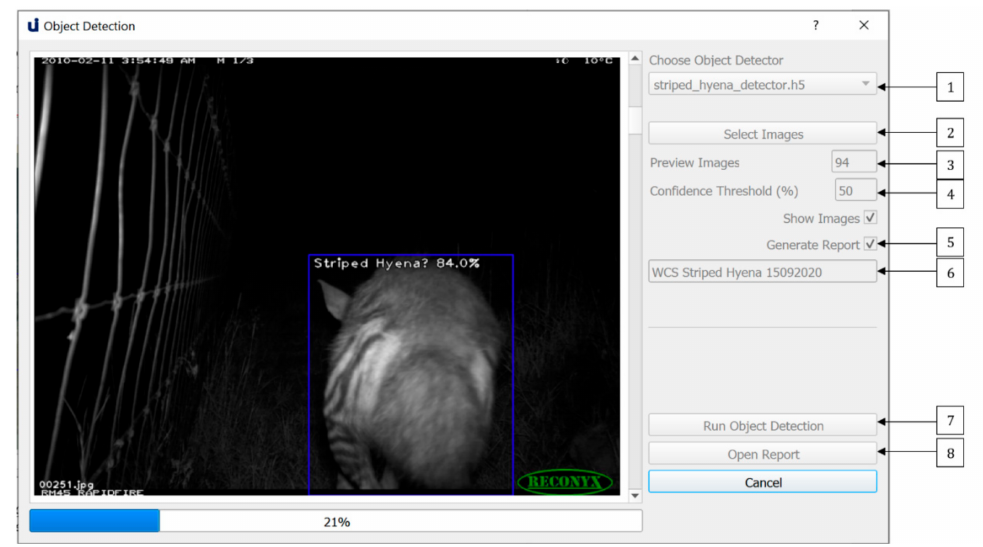
Figure 2. The Object Detection dialogue allows users to perform object detection on a dataset of images, optionally generating an object detection report.